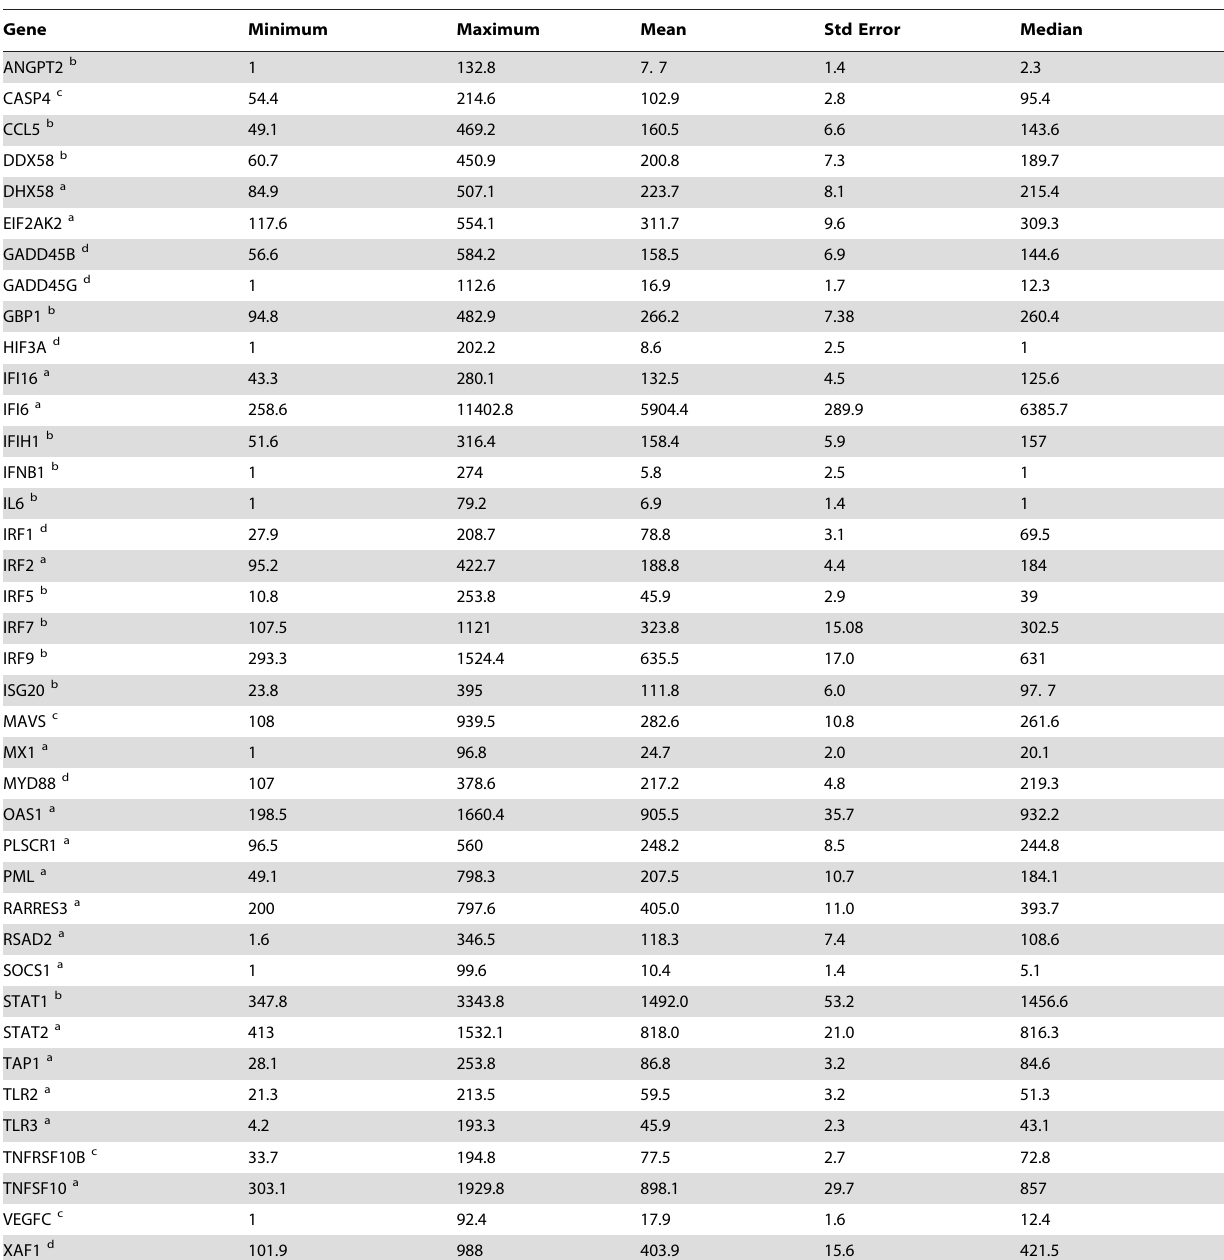
Table 2. Expression of the IFN Gene Signature.